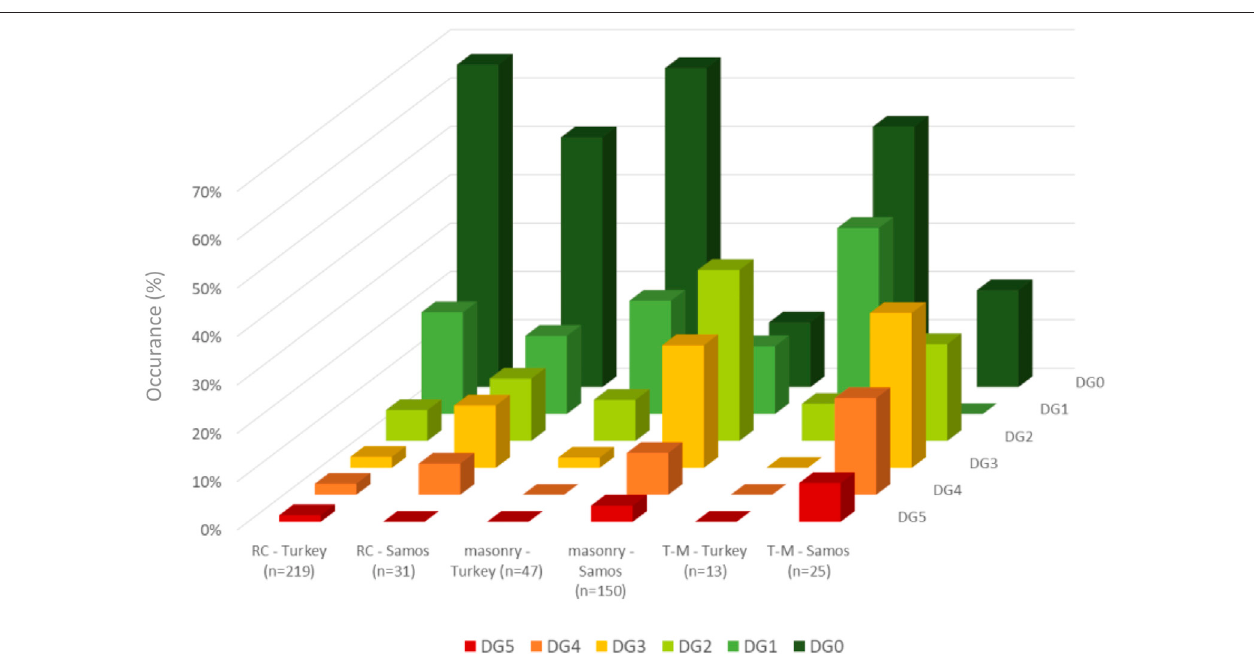
FIGURE 9 | Damage level distribution based on location and primary structural system (T-M stands for timber-masonry).